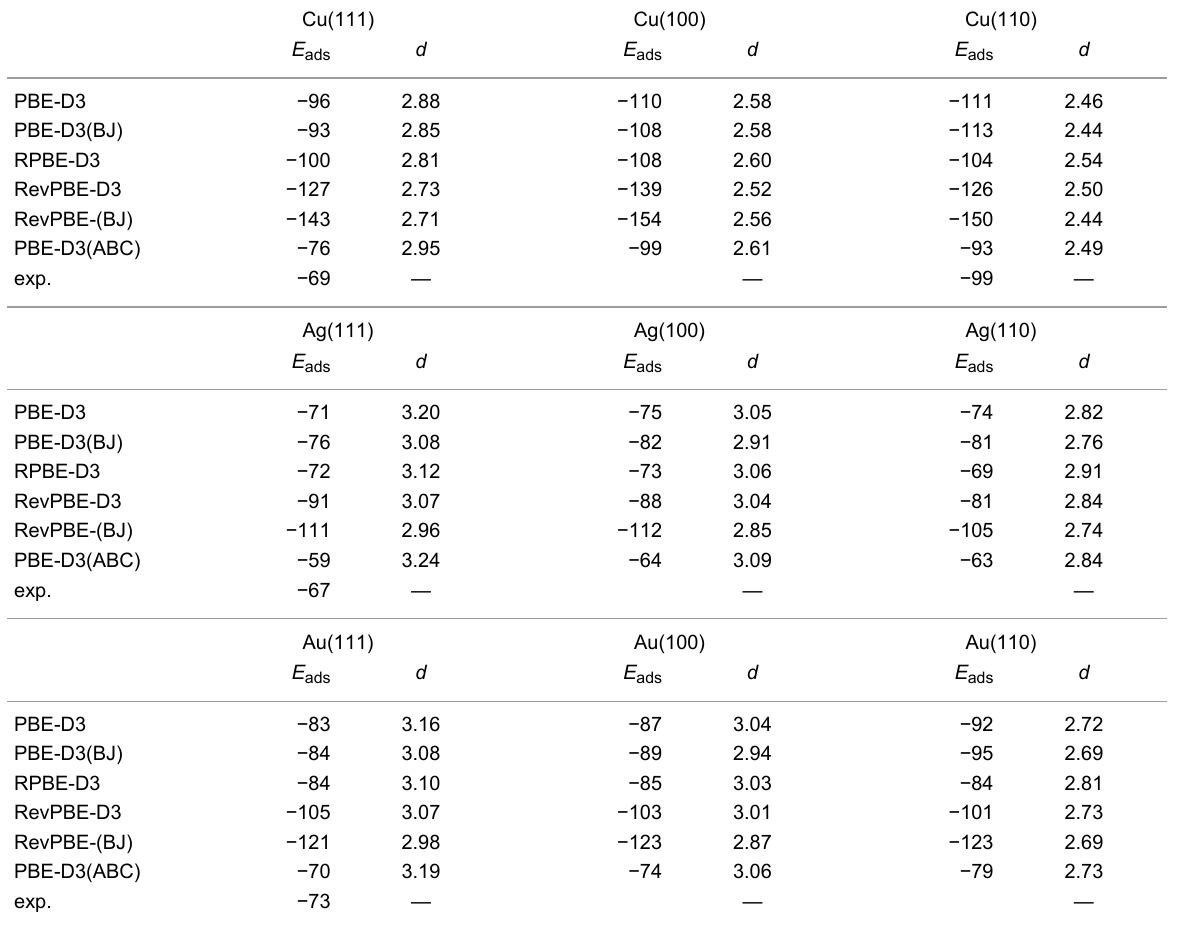
Table 2: Results for the adsorption of benzene obtained from potential curves. E ads is given in kJ/mol, d is given in